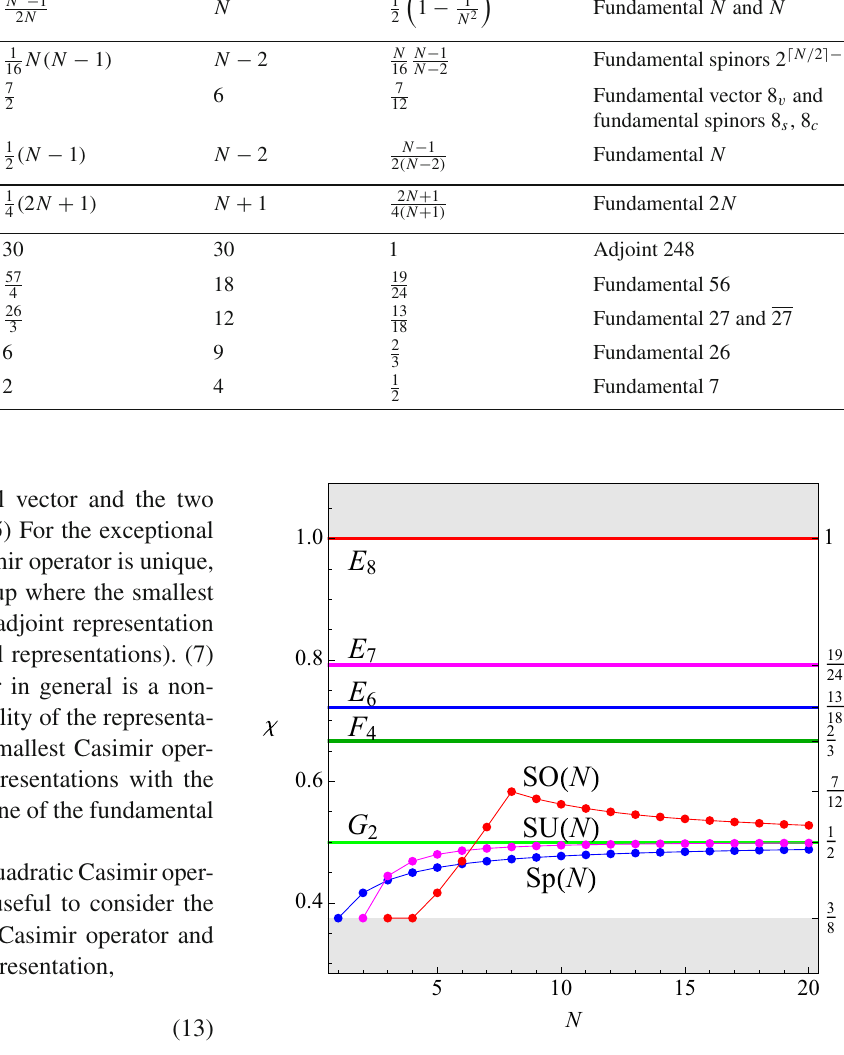
Fig. 1 Shown is the ratio χ , see (13)—the smallest achievable quadratic Casimir operator in units of the Casimir operator in the adjoint representation—for all simple Lie algebras. The grey areas ≤ χ ≤ 1. The lower show the excluded domains. We observe that 3 8 bound is achieved for the fundamental two-dimensional representa- tion of SU ( 2 ) (cid:10) SO ( 3 ) (cid:10) Sp ( 1 ) , and for the two inequivalent two- dimensional representation of SO ( 4 ) . For the exceptional groups the smallest Casimir operator grows with the rank of the group. The upper bound is achieved for E 8 . In all cases, the smallest quadratic Casimir operatorisachievedfortheirreduciblerepresentationofsmallestdimen- sionality N for SU ( N ) and Sp ( N ) , interpolating between 3 for small 8 N and 1 in the infinite- N limit. For SO ( N ) , we find that χ 2 to its maximum 7 at N = 8, from where grows from 3 8 12